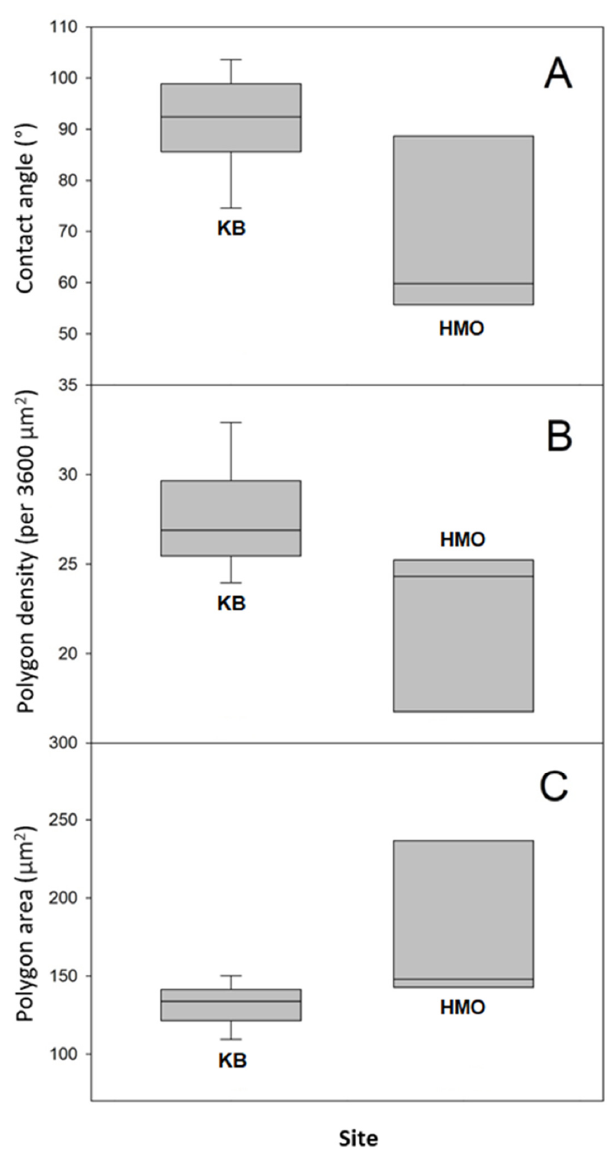
Figure 5. Boxplots of apparent contact angle and microscopic measurements performed to contrast the hydrophobicity and microstructures of Sonoran Desert beetle specimens collected in both sampling sites ( A ), contact angles; ( B ) polygon densities; and ( C ) average polygon areas. Note that smaller polygons (or higher polygon density in the honeycomb-like micro- structure) should contribute to a higher hydrophobicity. In fact, high polygon densities should enhance the formation of air pockets in the gaps between polygons, thus promot- ing larger apparent contact angles [14,15] (see discussion and Figure 8). In order to have more insight into this idea, we plotted the contact angle value as a function of the number of polygons per unit square (60 by 60 μ m 2 ), as shown in Figure 6. We can appreciate that, as a general trend, the apparent contact angles increase as the number of polygons in- creases. However, if one looks for a quantitative correlation between the data with a linear regression analysis, the coefficient of determination is rather low (R 2 = 0.38). This fact in- dicates that the measured contact angles are poorly correlated with the average polygon number per unit area. This is probably an indication that other factors, such as the elytra